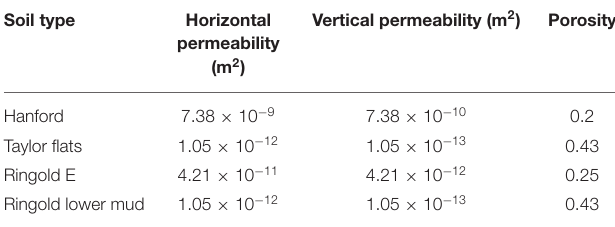
TABLE 1 | Hydrogeologic properties of geologic